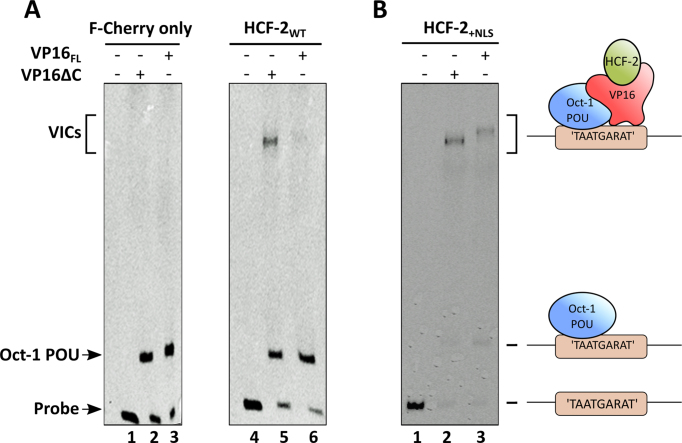
HCF-2 fails to form a VIC with VP16FL (A), but addition of HCF-1 NLS sequence to the C-terminus of HCF-2 activates VIC formation with VP16FL (B). Immunopurified F-Cherry, F-Cherry-HCF-2WT or F-Cherry-HCF-2+NLS proteins were used for EMSA assay (see ‘Materials and Methods’ section). Lanes 1 and 4, probe alone with Oct-1 POU domain; lanes 2 and 5, Oct-1 POU domain and VP16ΔC; lanes 3 and 6, Oct-1 POU domain and VP16FL. (A) and (B) represent two different gels; models of VIC composition and formation are shown.